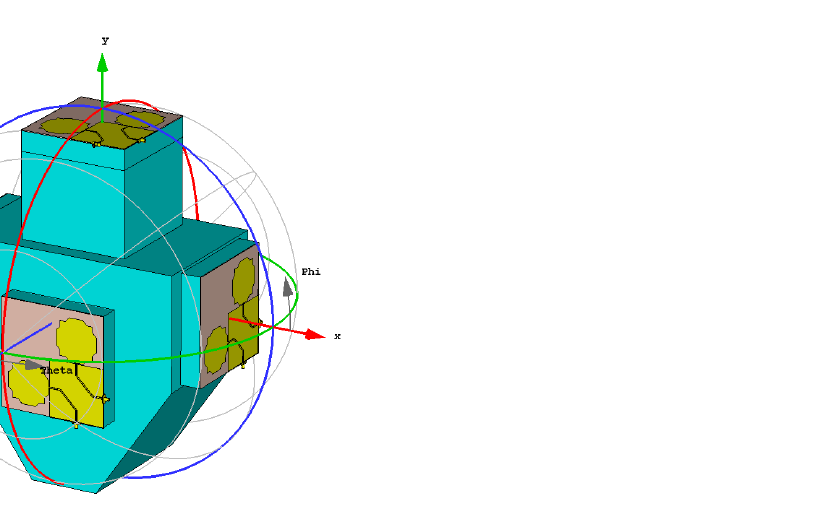
Figure 22. Proposed antenna system configuration.